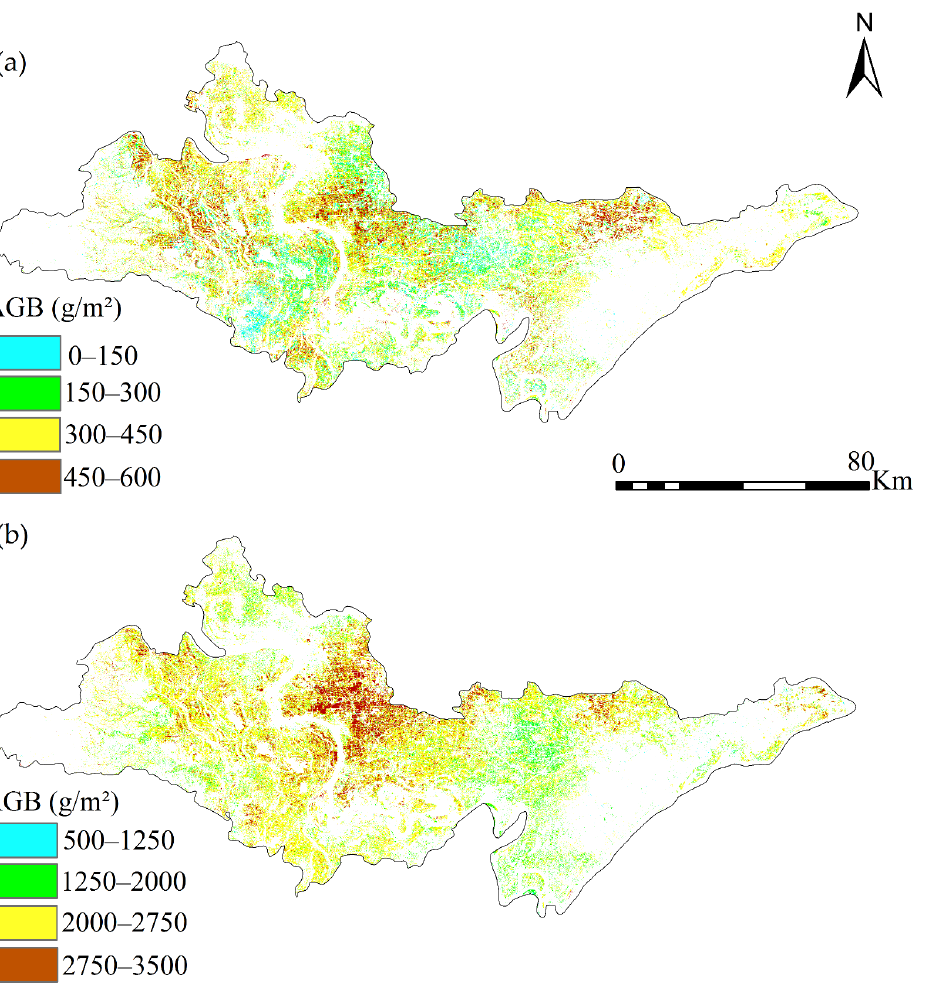
Figure 17. Monitoring results of rice growth in pre-heading stage ( a ) and post-heading stage ( b ).